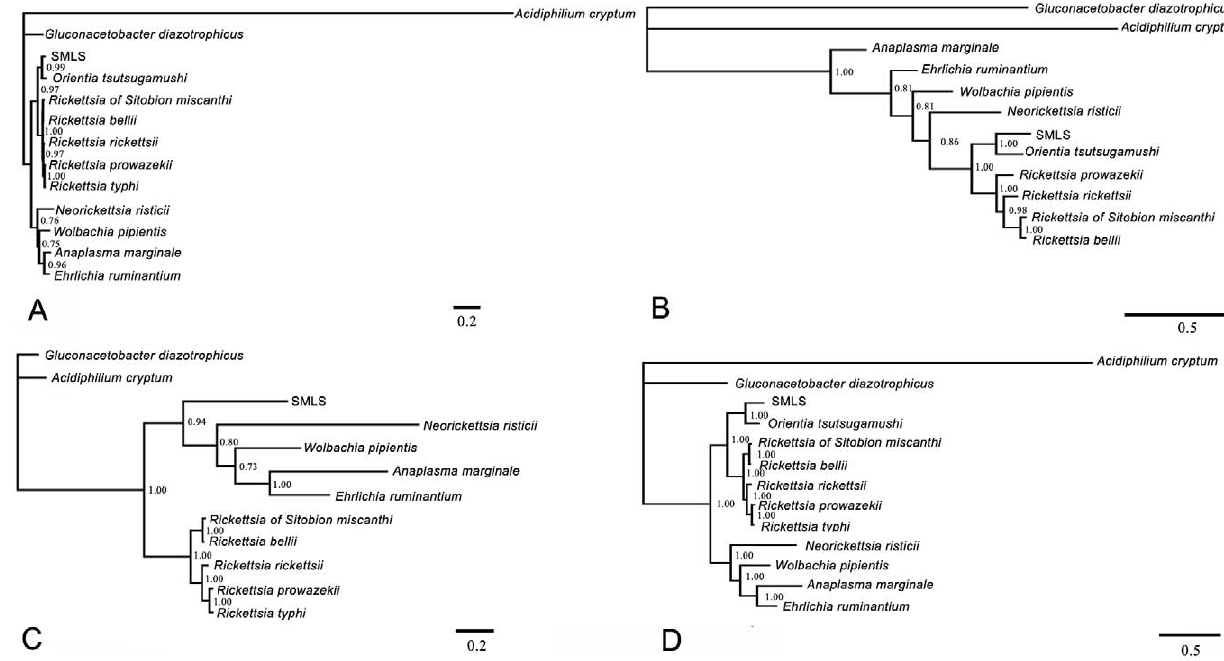
Figure 1. Bayesian inference trees were constructed with individual gene and the concatenated data of all loci. A, 16S rRNA tree; B, coxA gene tree; C, gltA gene tree; D, concatenated data tree. Numbers near nodes indicate Bayesian posterior probabilities . 0.5. The bar indicates the estimated number of substitutions per site.